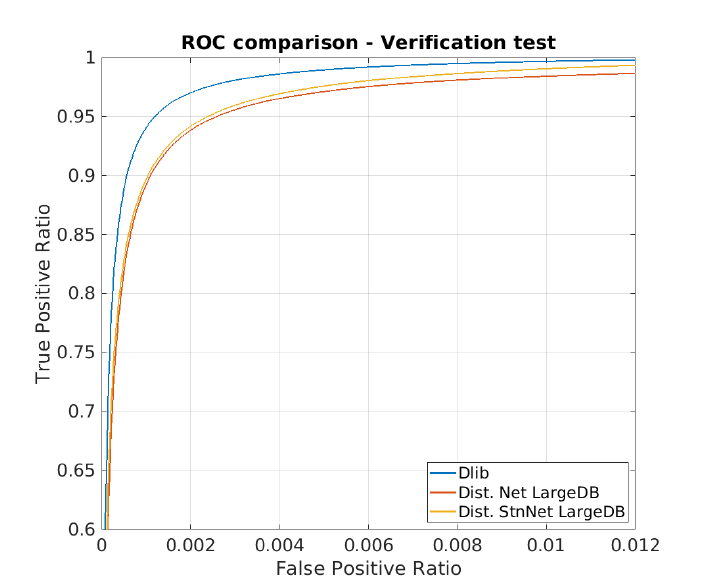
Figure 9. ROC curve for the LFW face verification test. Note that the graphs are highly zoomed portions of the entire